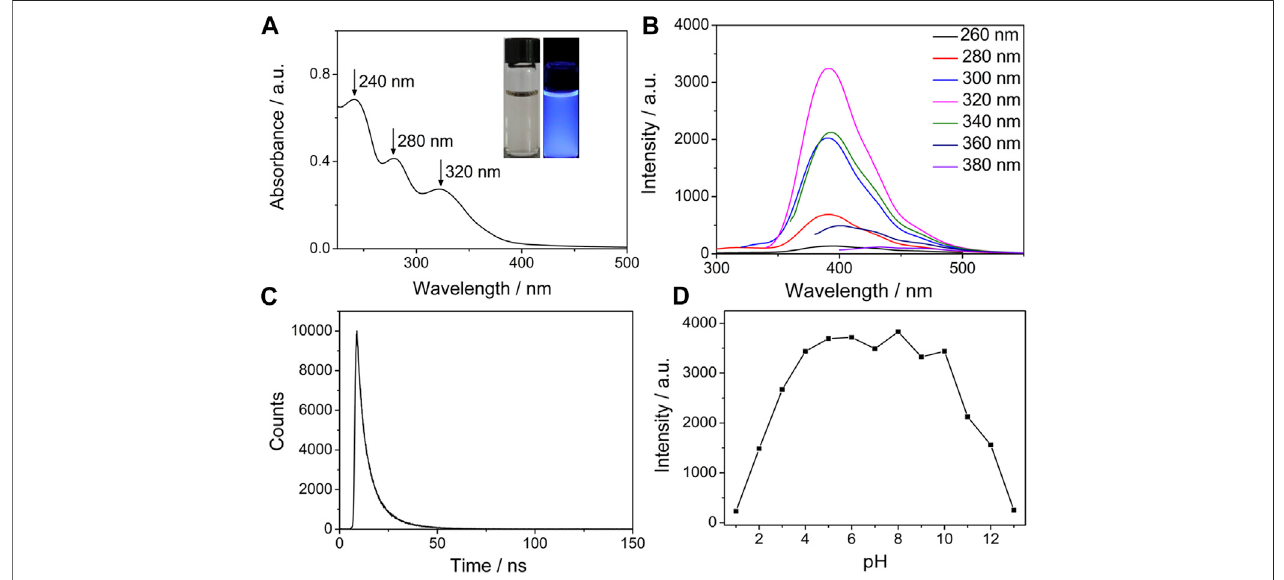
FIGURE2|(A) AbsorptionspectrumofN/PCDs(10 μ g · mL − 1 ).(Insert:N/PCDssolutionunderdaylight(left)andUVlight(right)). (B) Excitation-dependentemission spectraofN/PCDs(10 μ g · mL − 1 ). (C) FluorescencedecaycurveofN/PCDs(10 μ g · mL − 1 )under320 nmexcitation. (D) EffectofpHonthe fl uorescenceintensitiesofN/P CDs (10 μ g · mL − 1